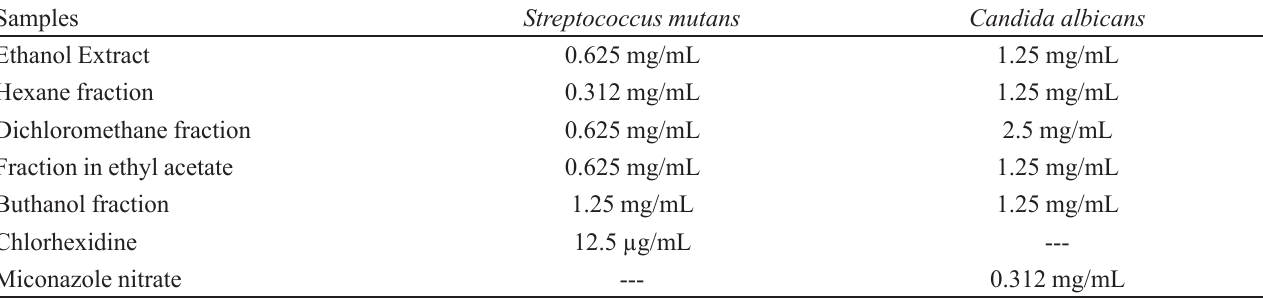
TABLE IV - Test results for MIC of ethanol extract and fractions of Rosmarinus officinalis , chlorhexidine and miconazole nitrate